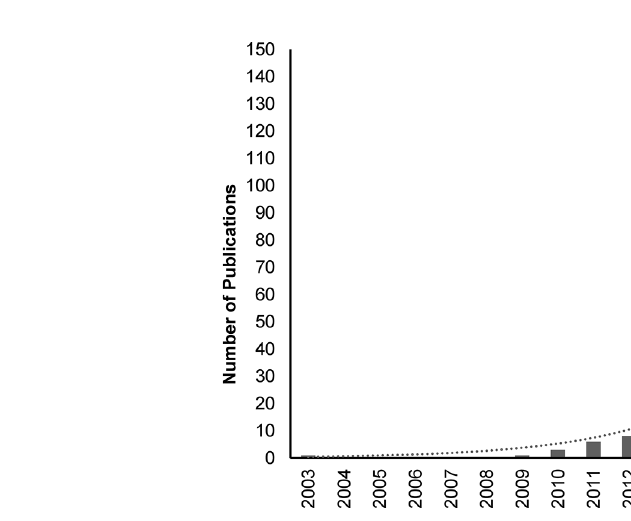
FIGURE 1 | PubMed-indexed peer-reviewed publications on IL-37 between 2003 and 2020. Search was performed on 12 th January 2021 using the following search terms: IL37, IL-37, IL 37, Interleukin-37, Interleukin37, Interleukin 37. Dotted line: exponential